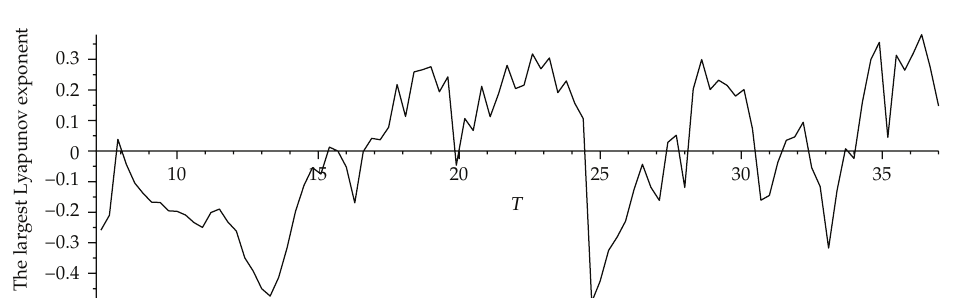
Figure 7: The largest Lyapunov exponents (cid:2) LLE (cid:3) corresponding to Figure 2.